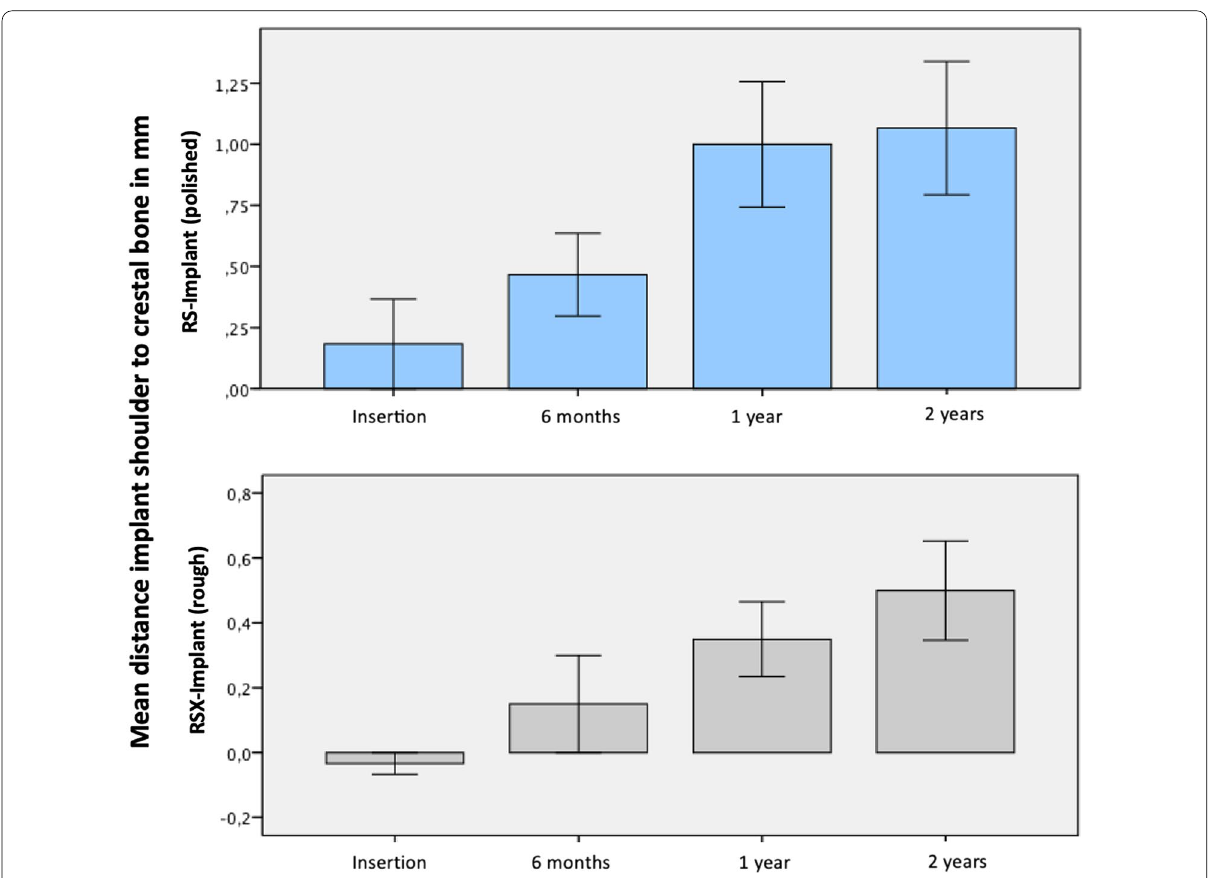
Fig. 6 Distance from implant shoulder to the first bone-to-implant contact in both